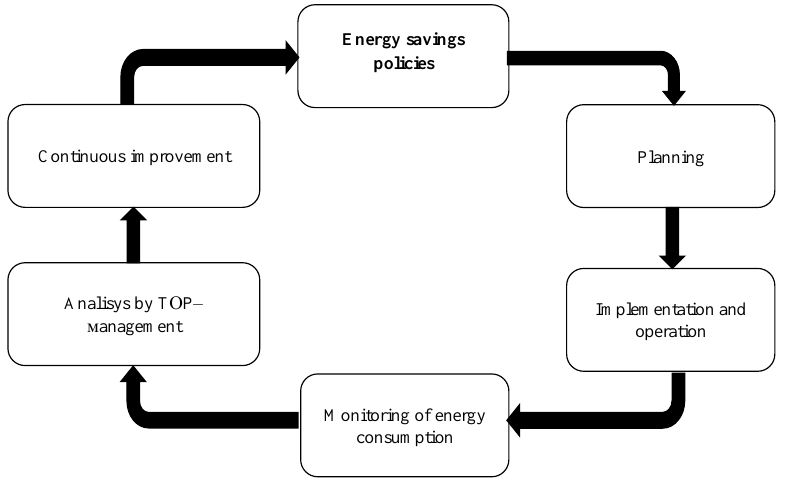
Figure 5. Industrial energy efficiency improvement strategy. Note: compiled by the authors.